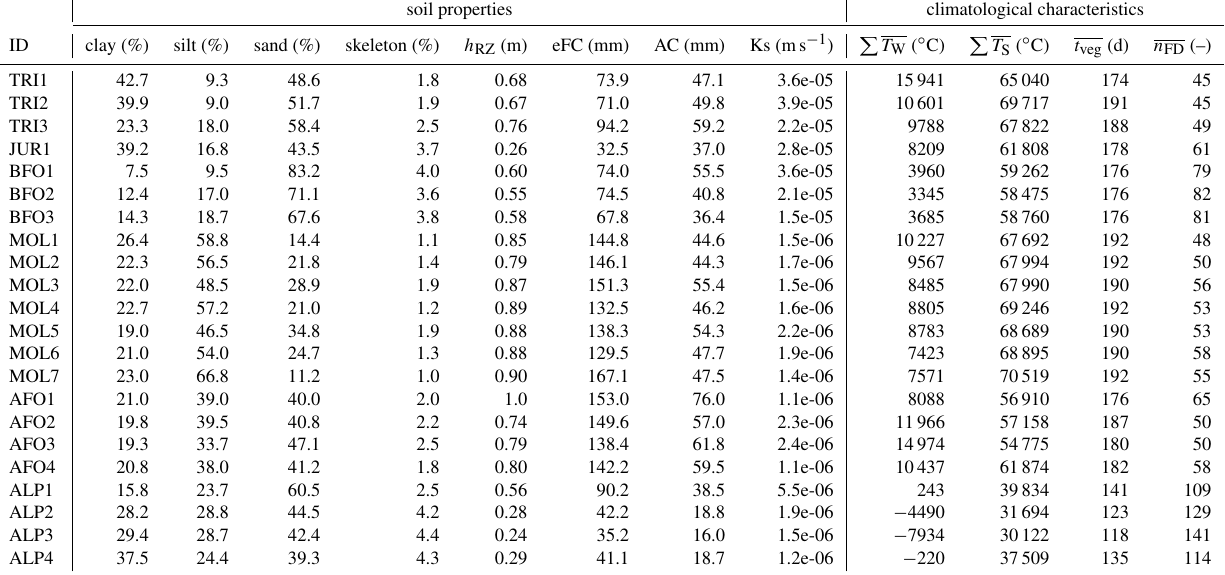
Table A2. Soil properties and climatological characteristics of the test catchments. Next to the site identifier (ID) the columns contain average clay, silt, sand, and skeleton contents, root zone depth ( h RZ ), effective field (eFC) and air capacity (AC) therein, and the corresponding average saturated hydraulic conductivity (Ks). All soil properties are provided by the national soil map of Germany (Hartwich et al., 1995) except for Ks, which was estimated based on pedo-transfer functions (Schaap et al., 2001). The climatological variables include 4-year mean winter and summer temperature sums ( P T W and P T S ), the length of the period of vegetation ( t veg ), and the number of frost days ( n FD